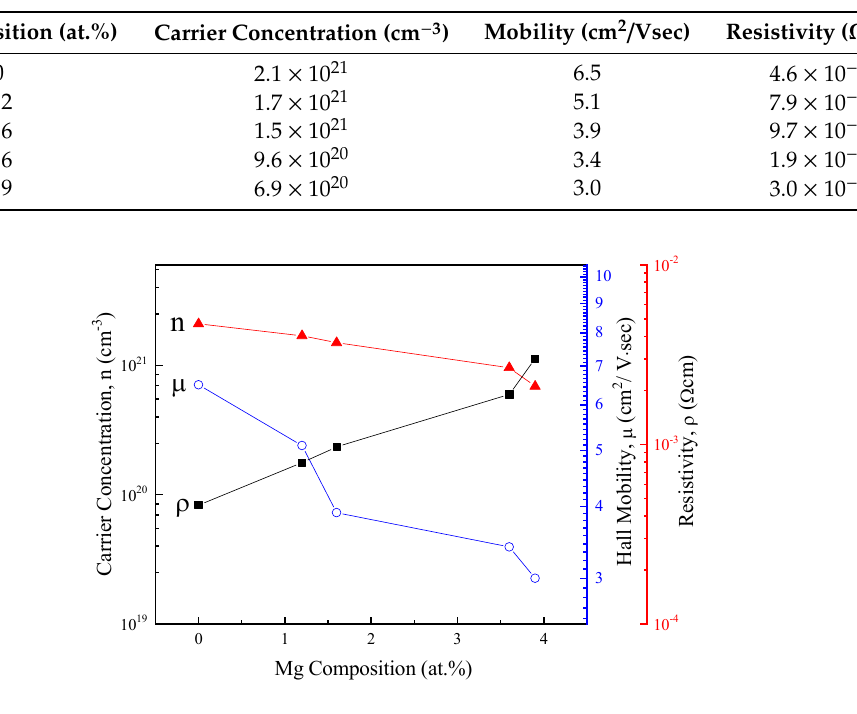
Figure 2. Variations of the electrical resistivity ( ρ ), carrier concentration ( n ), and mobility ( μ ) of the films annealed at 600 °C.